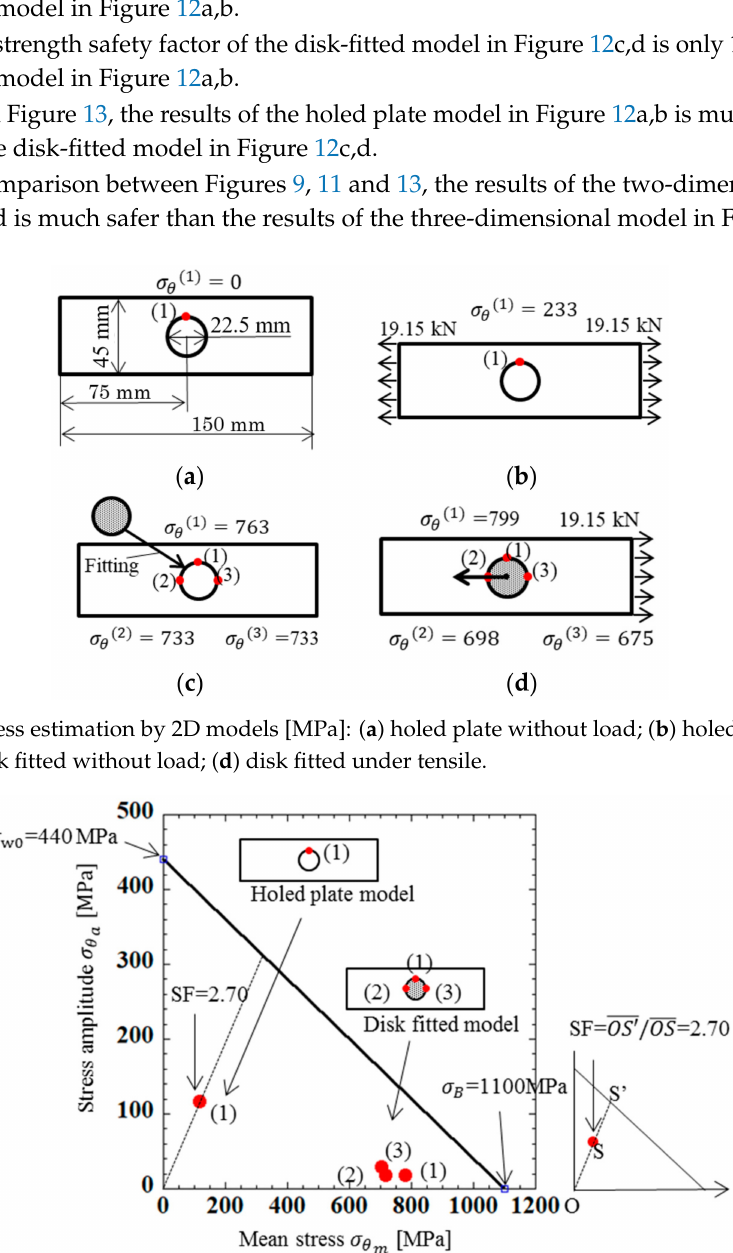
Figure 13. Fatigue limit diagram for 2D